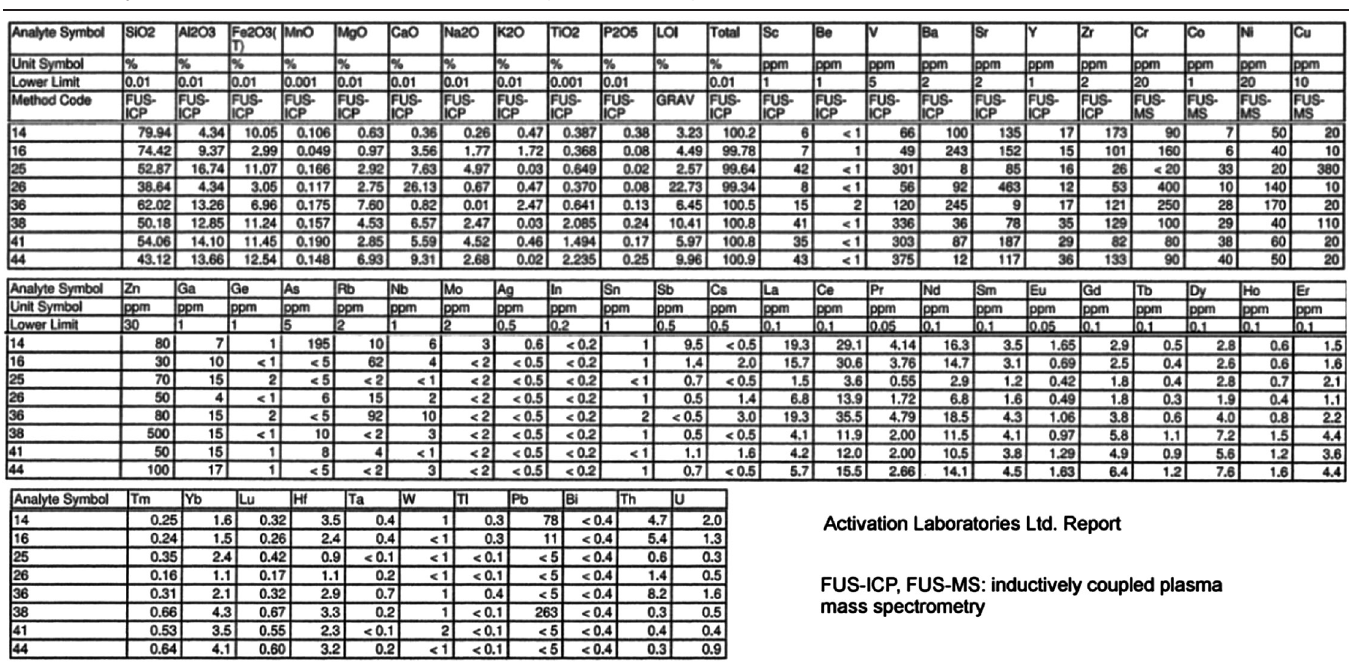
Table 2a. Major and trace elements for the Vardar zone (FICP and